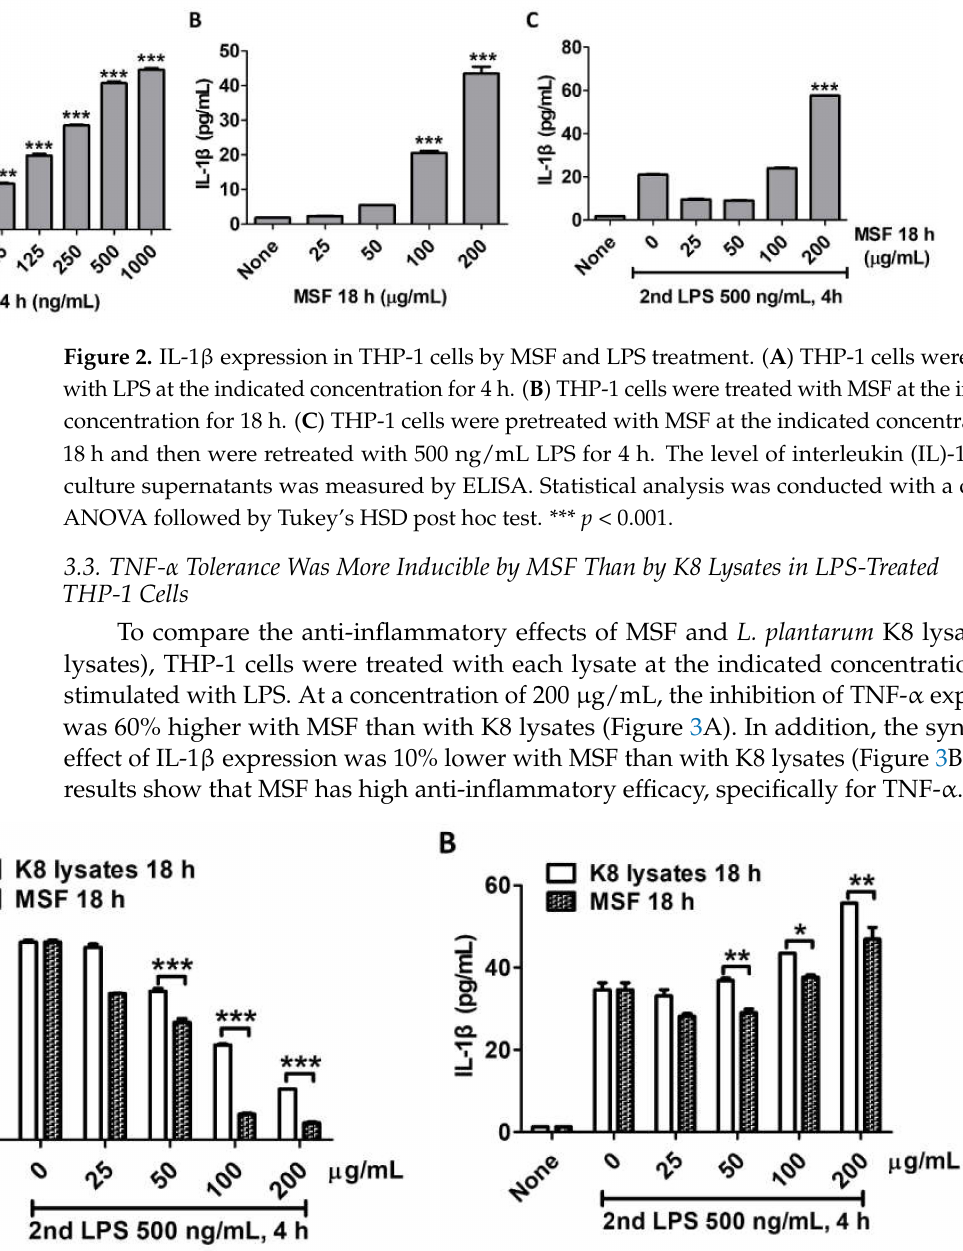
Figure 3. Comparison of anti-inflammatory responses induced by MSF or L. plantarum K8 lysates. ( A , B ) THP-1 cells were treated with MSF and L. plantarum K8 lysates, respectively, at the indicated concentration for 18 h, and cells were retreated with 500 ng/mL LPS for 4 h. The levels of cytokines in the culture supernatants were measured by ELISA. Statistical analysis was conducted with two-way ANOVA (G). * p < 0.05; ** p < 0.01; *** p <